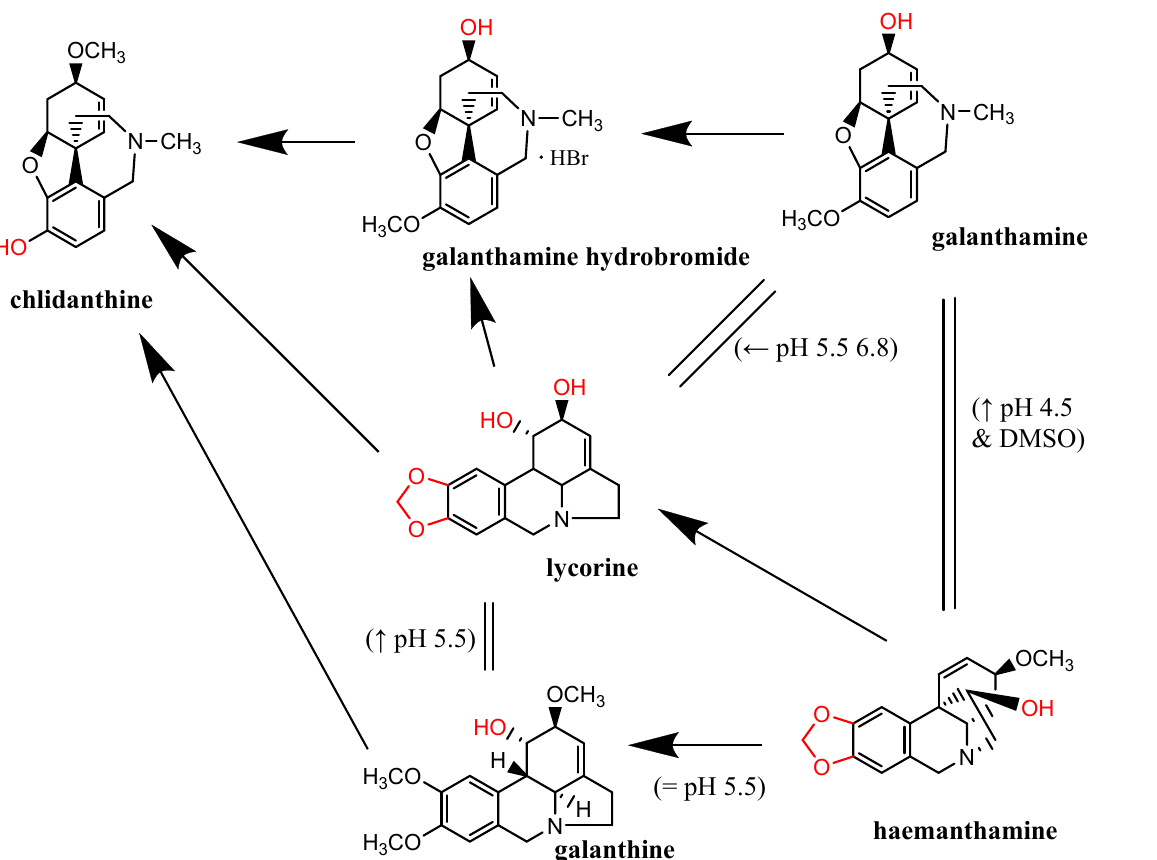
Figure 9. Graphical depiction of cupric-reduction potencies of alkaloids isolated from Amaryllidaceae family. Arrows point to stronger reduction compounds. Exceptions to the general scheme are shown in parentheses encompassing conditions.